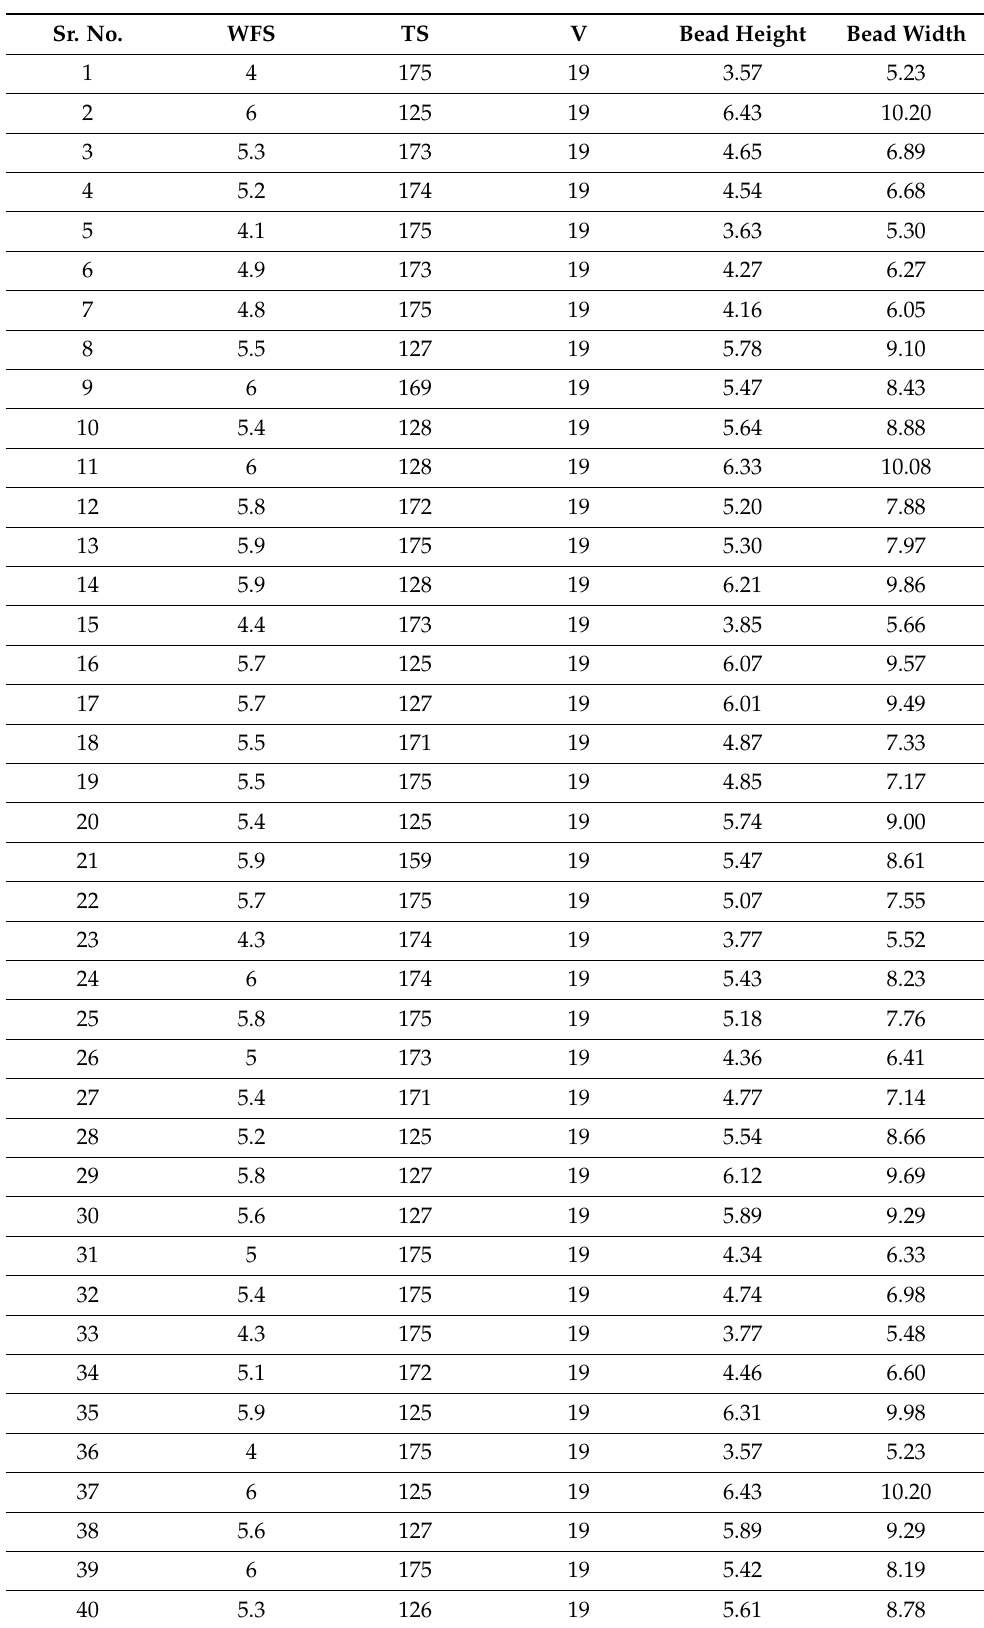
Table 8. Pareto optimal